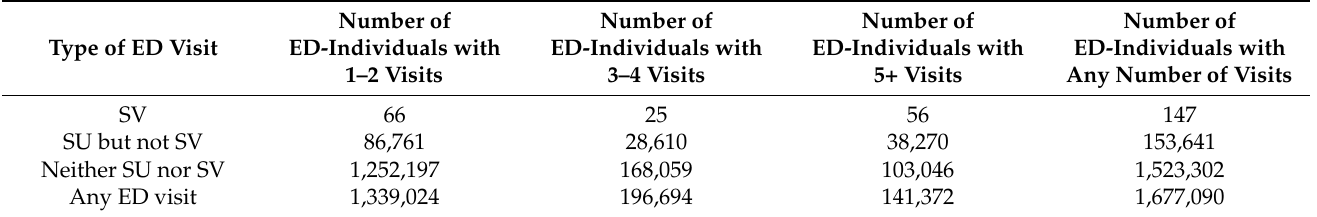
Table 4. Number of ED-Individuals with ED Visits Involving Sexual Violence and/or Substance Use in Hawaii,